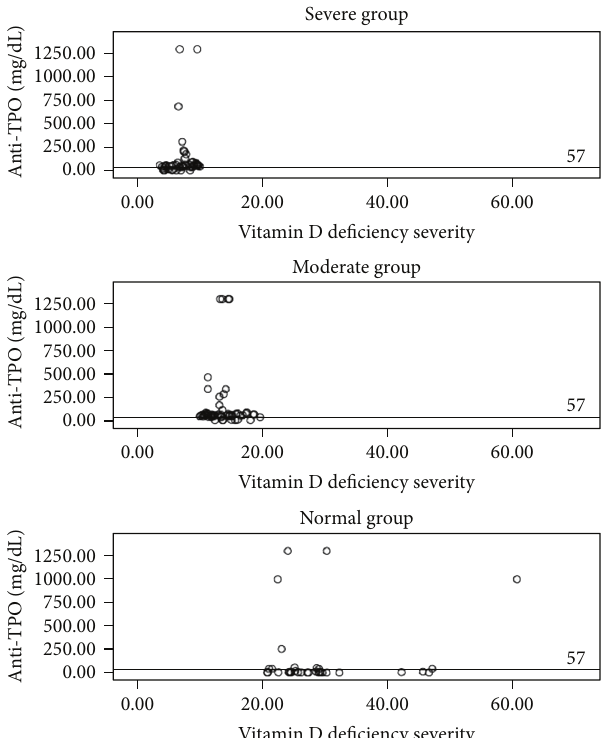
Figure 3: The correlation between anti-TPO and vitamin D in each group. The cut-off value for negative anti-TPO concentration is < 57 IUmL −1